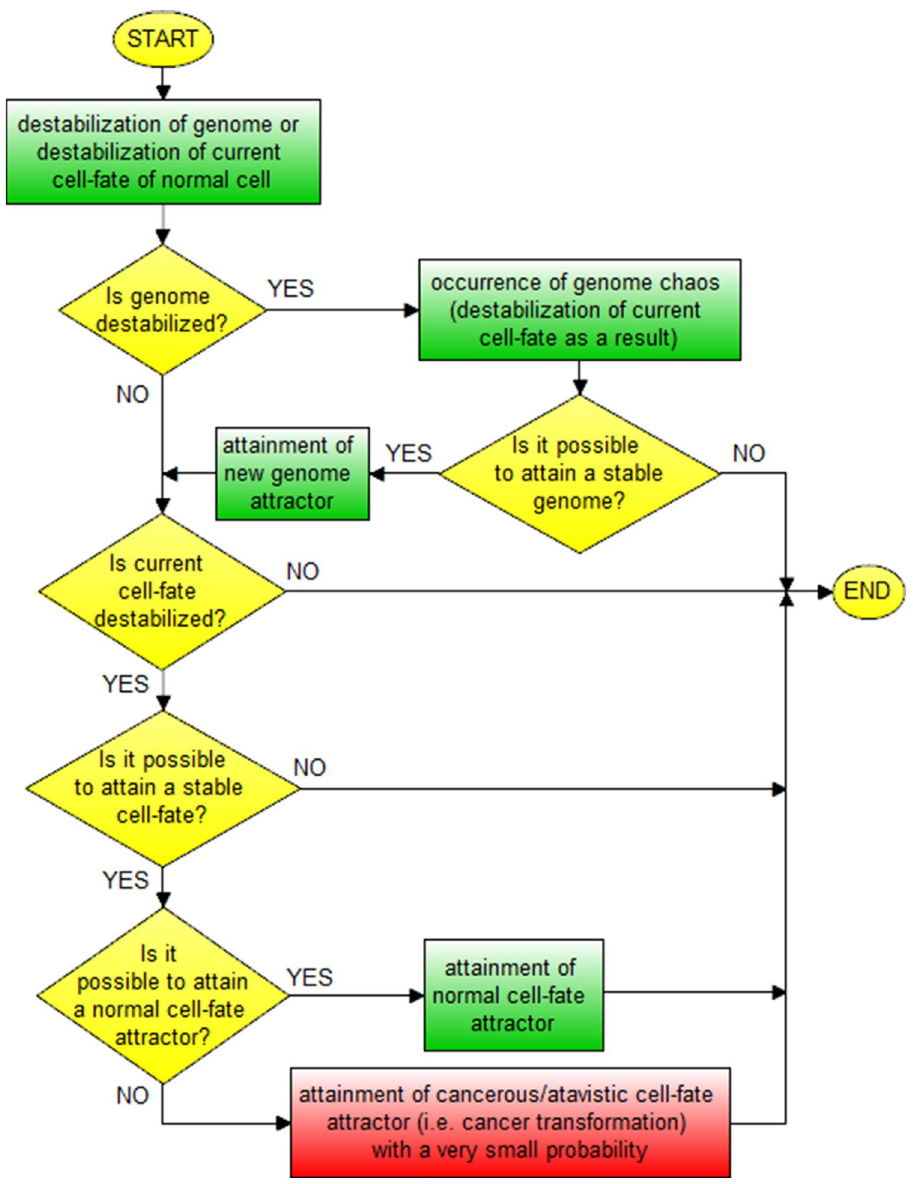
Figure 9. Block schema of cancer transformation.